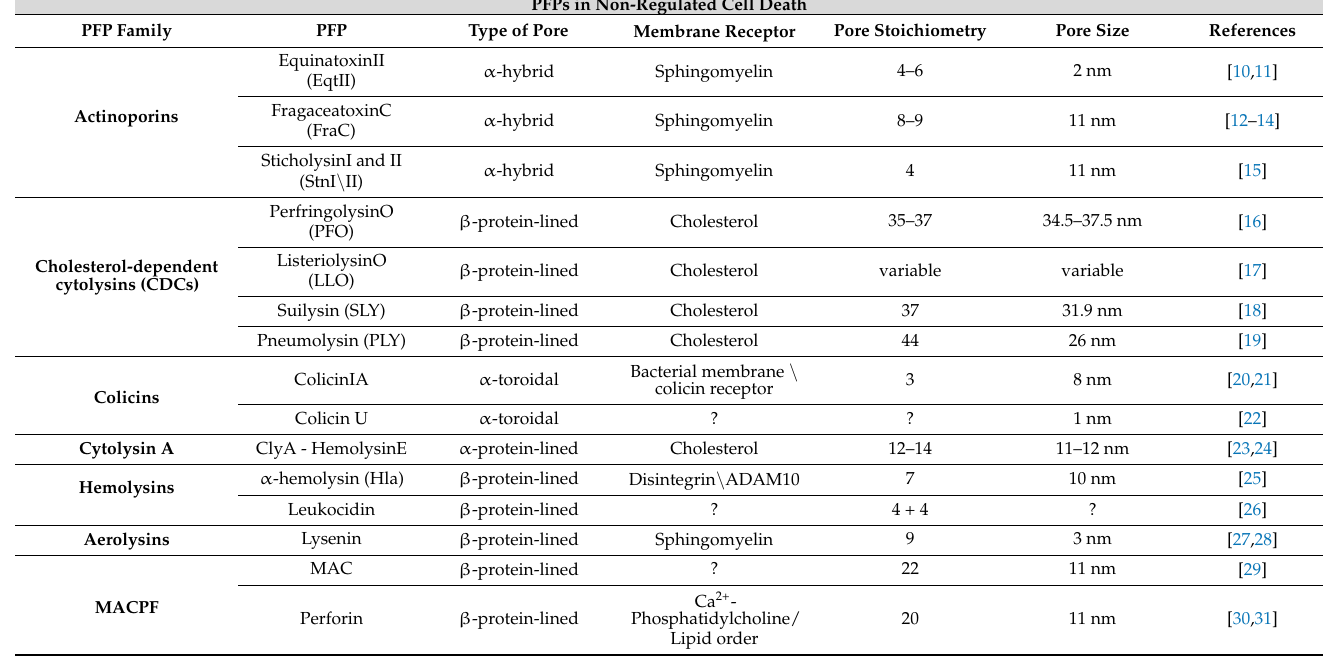
Table 1. Classification of PFPs and details on pores and pore